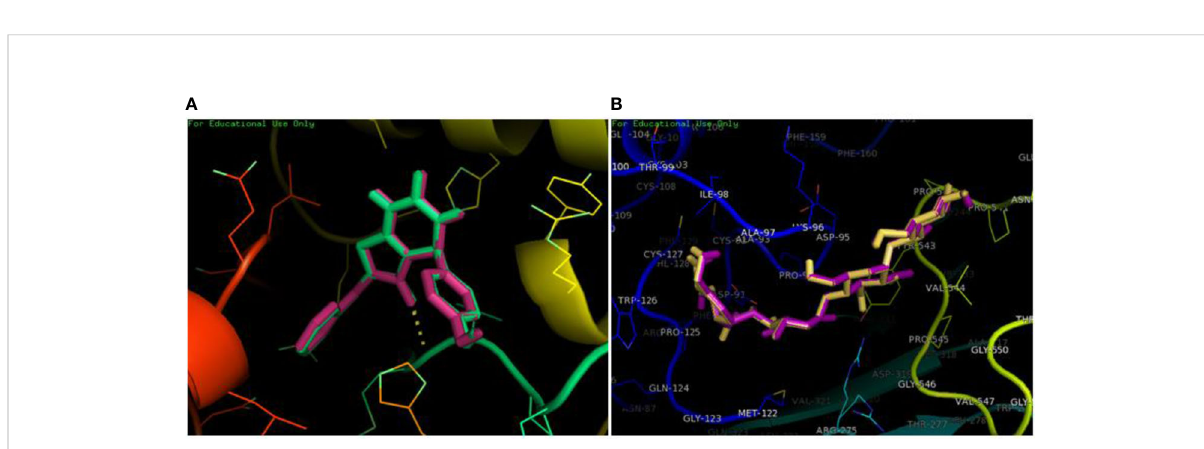
FIGURE 3 Superimposition of redocked complex with the reference complex. (A) The redocked complex of active compound is superimposed onto the reference conformation in the active binding site of protein. (B) The redocked complex of standard acarbose is superimposed onto the reference conformation in the active binding site of protein.